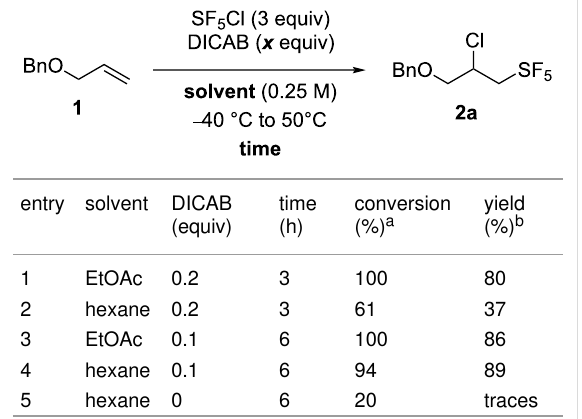
Table 3: Effect of time and amount of the amine–borane complex on the SF 5 Cl addition on allyl benzyl ether ( 1